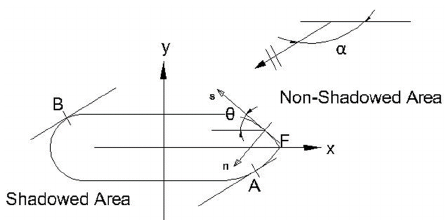
Figure 10. Coordinate system in calculating drift force due to reflection.